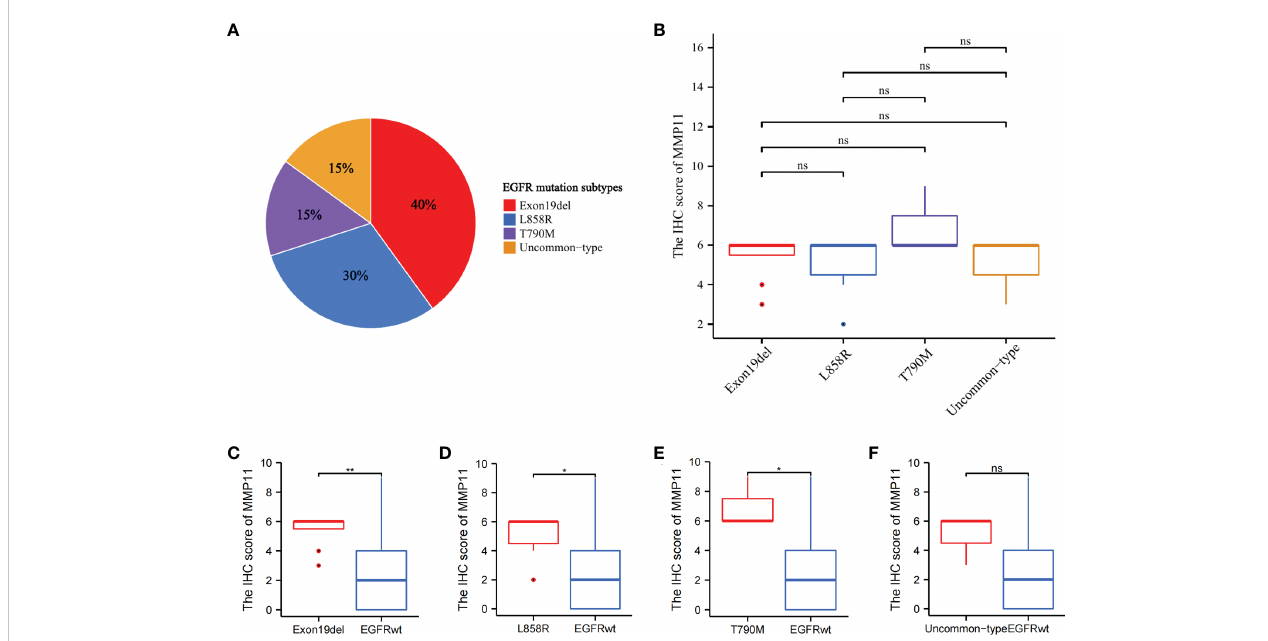
FIGURE 3 Differential expression of MMP11 between different EGFR mutation subtypes at the level of IHC scores. (A) Proportion of EGFR-mutant samples by mutation subtypes among 20 EGFR-mutant LUAD clinical samples, the Exon19del group is red, the L858R group is blue, the T790M group is purple, the uncommon- type group is yellow (pie chart); (B) The differences in MMP11 ICH scores between the Exon19del group (red), the L858R group (blue), the T790M group (purple), the uncommon-type group (yellow); (C) Differences in MMP11 IHC scores between the Exon19del and EGFR-wild groups; (D) Differences in MMP11 IHC scores between the L858R and EGFR-wild groups; (E) Differences in MMP11 IHC scores between the T790M and EGFR-wild groups; (F) Differences in MMP11 IHC scores between the uncommon-type group and EGFR-wild groups; *P < 0.05; **P < 0.01; ns, no statistical signi fi